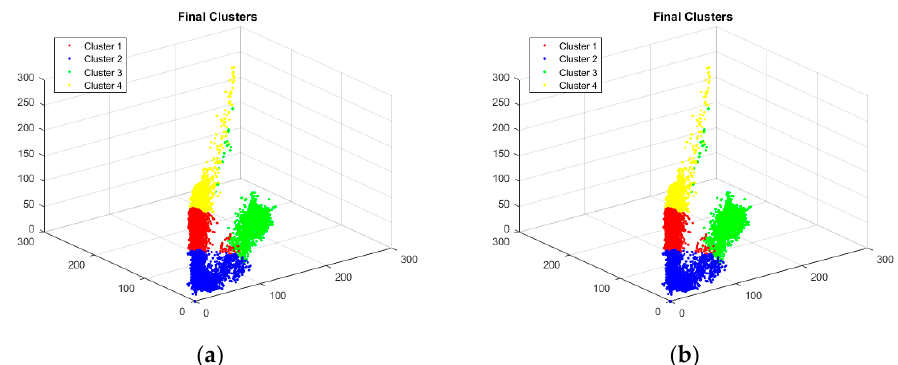
Figure 9. Clusters produced by ( a ) our proposed implementation of parallel PAM with P = 64 and ( b ) K-Medoids clustering algorithm [17]. Final medoids locations and objective function value were same in both cases.